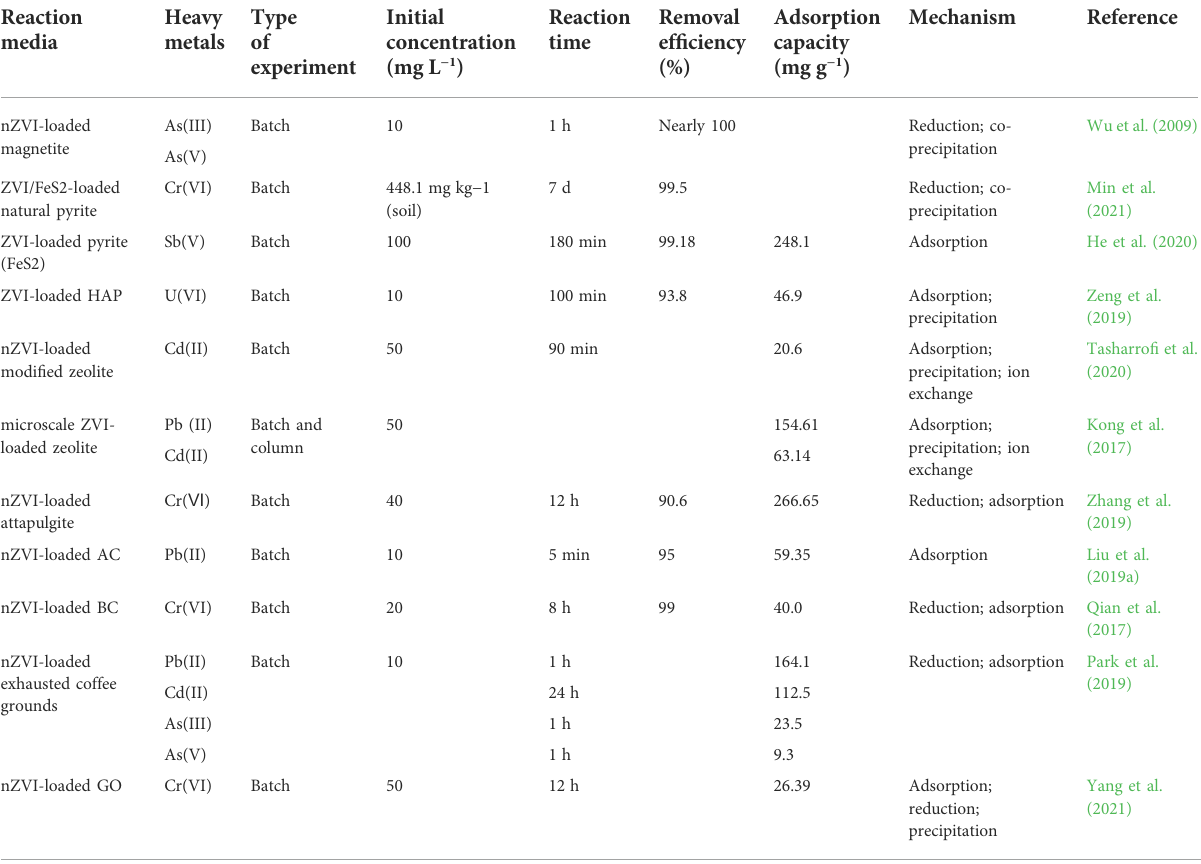
TABLE 4 Application of ZVI-loaded materials in PRB treatment of heavy metals in groundwater.